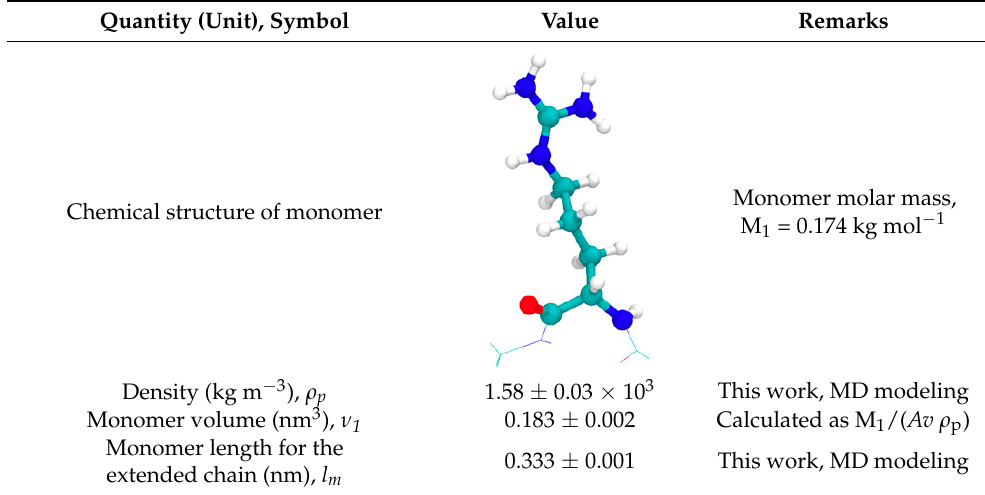
Table 1. Physicochemical characteristics of P-Arg molecule derived from MD modeling, T = 298 K.